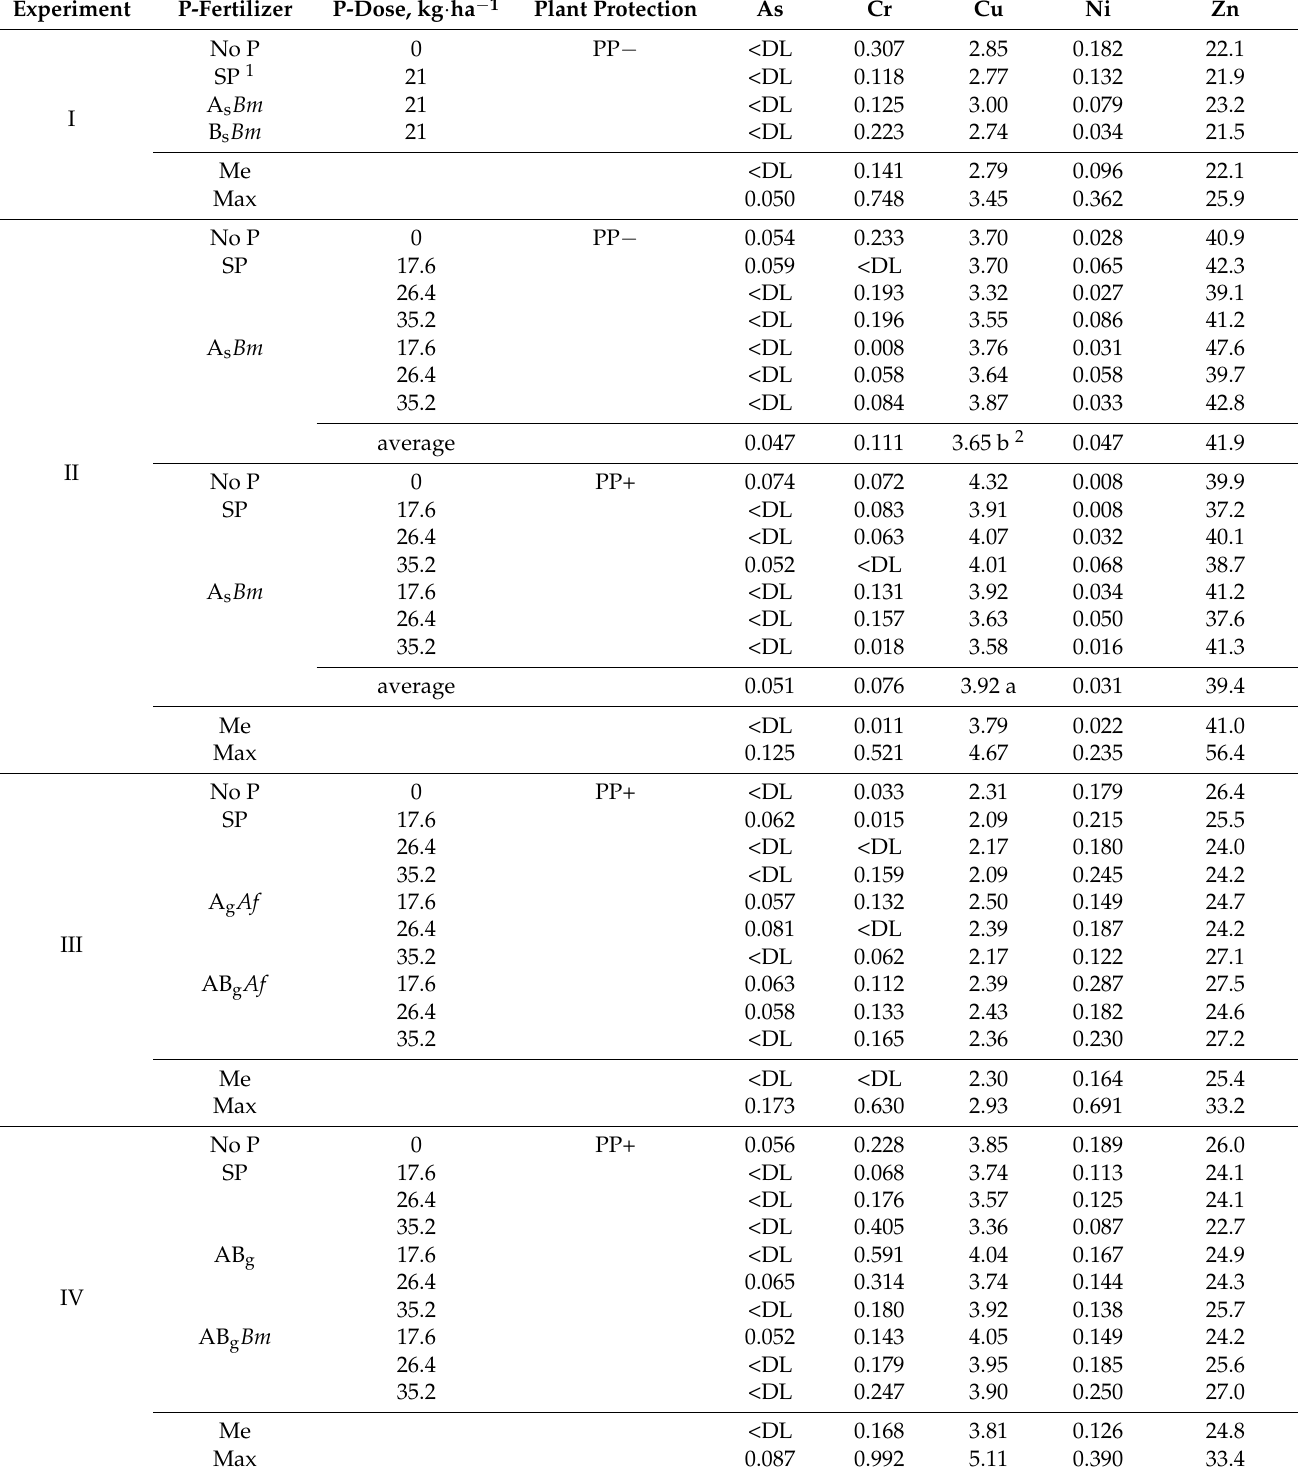
Table 11. PTE content in wheat grain, mg · kg − 1 DM (n = 4).